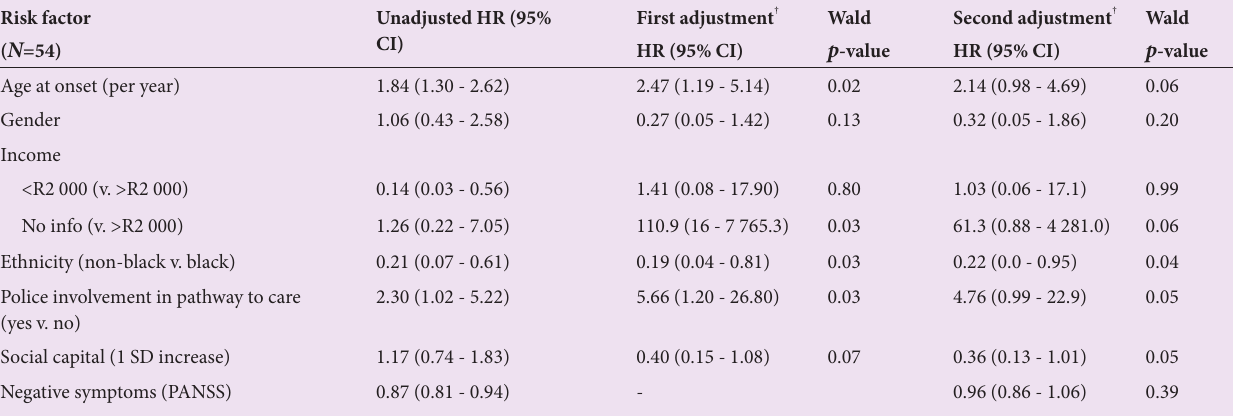
Ethnicity (non-black v. black)